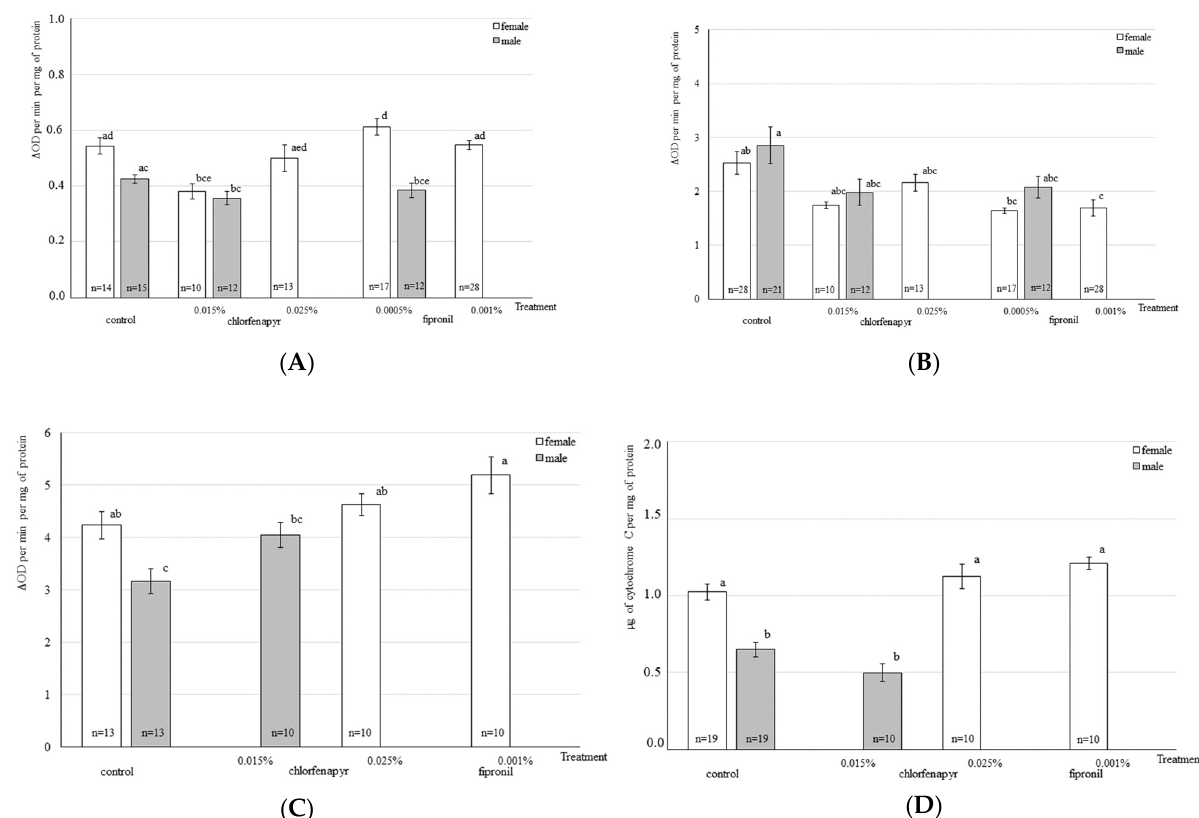
Figure 1. The enzyme activities in adults Musca domestica after exposure to insecticides at sublethal concentrations. Bars